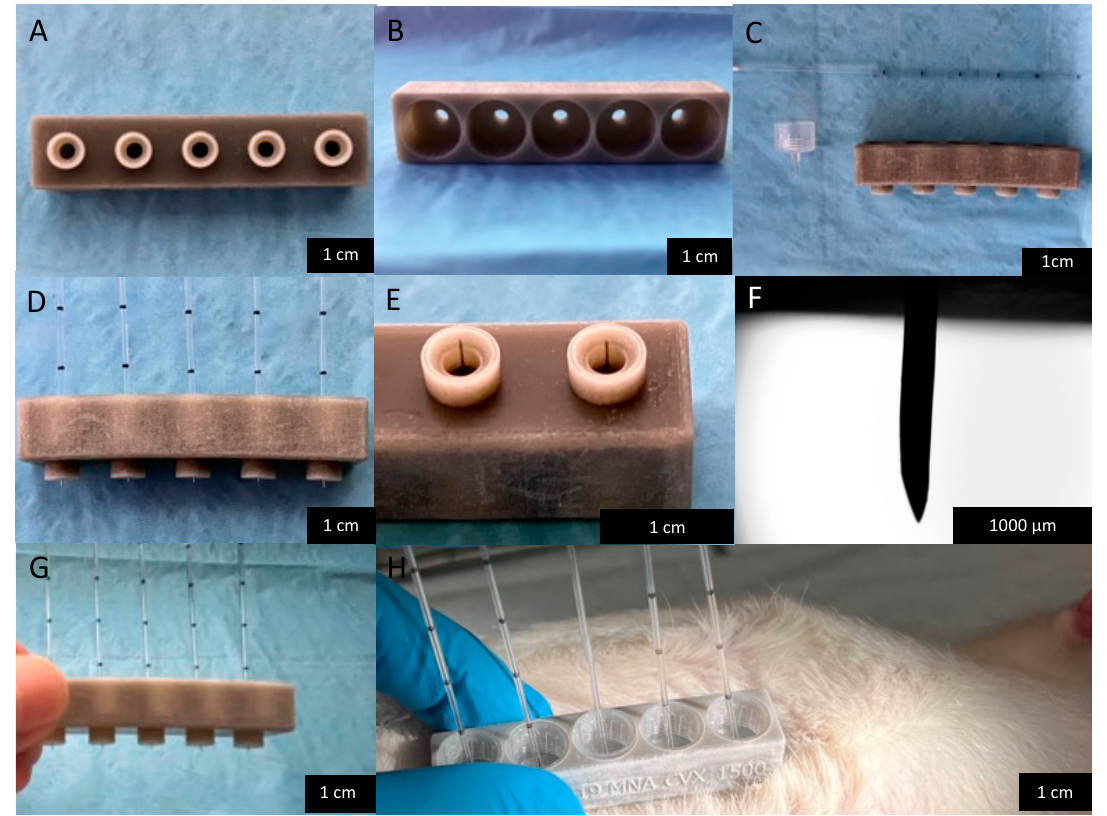
Figure 1. Microneedle Array (MA) is shown from the bottom side ( A ) and top side ( B ) . All three pieces of the assembly (needle, capillary tube, and microneedle array) are shown in ( C ) . The fully assembled MA is shown in ( D ), and a closer image of the MA tip with needles protruding ~1500 µ m is shown in ( E ). Light microscopy was used to visualize the needle tip length protruding from the tip of the MA in ( F ). The fully assembled MA being held in a hand is shown as a size reference in ( G ). Application of the MA in a Sprague Dawley rat with no hair removal is shown in ( H ) .